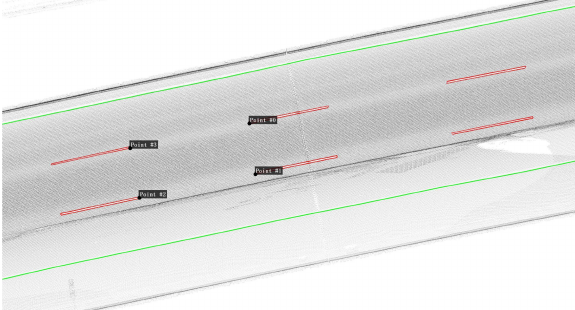
Figure 8. The DXF vectorized model together with the original point cloud of Highway 1 Dataset. Road marking corner points are manually selected from the original point cloud for vectorization accuracy